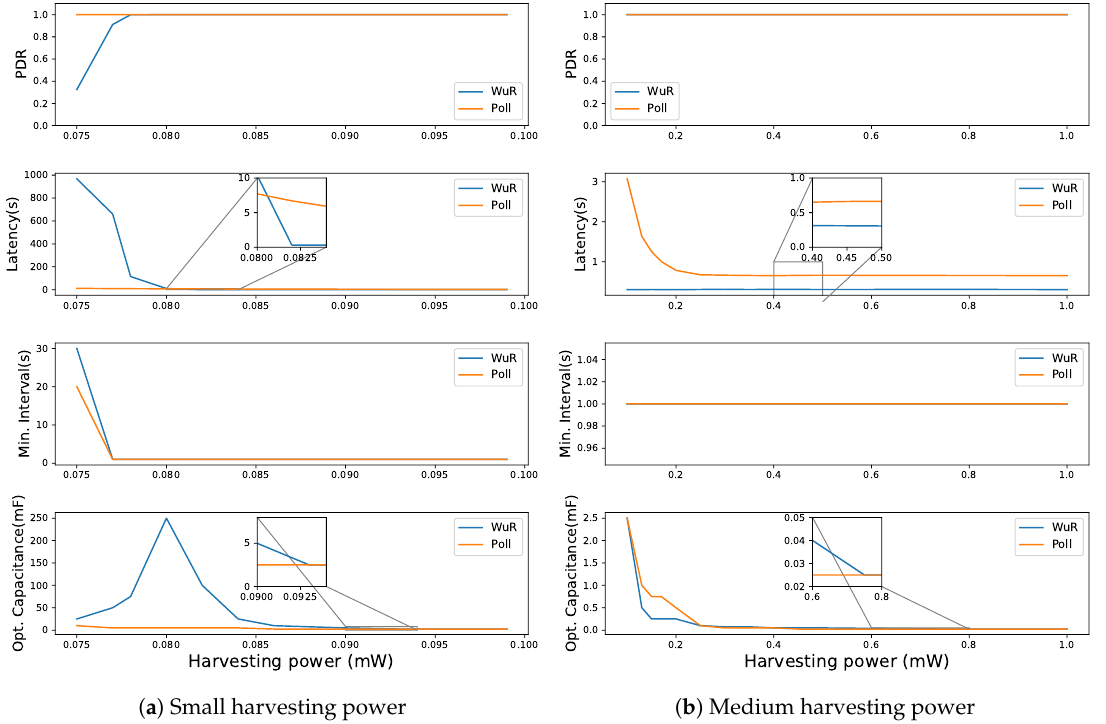
Figure 12. Comparing WuR-based and direct poll-based communication schemes for a Poisson packet arrival rate = 60